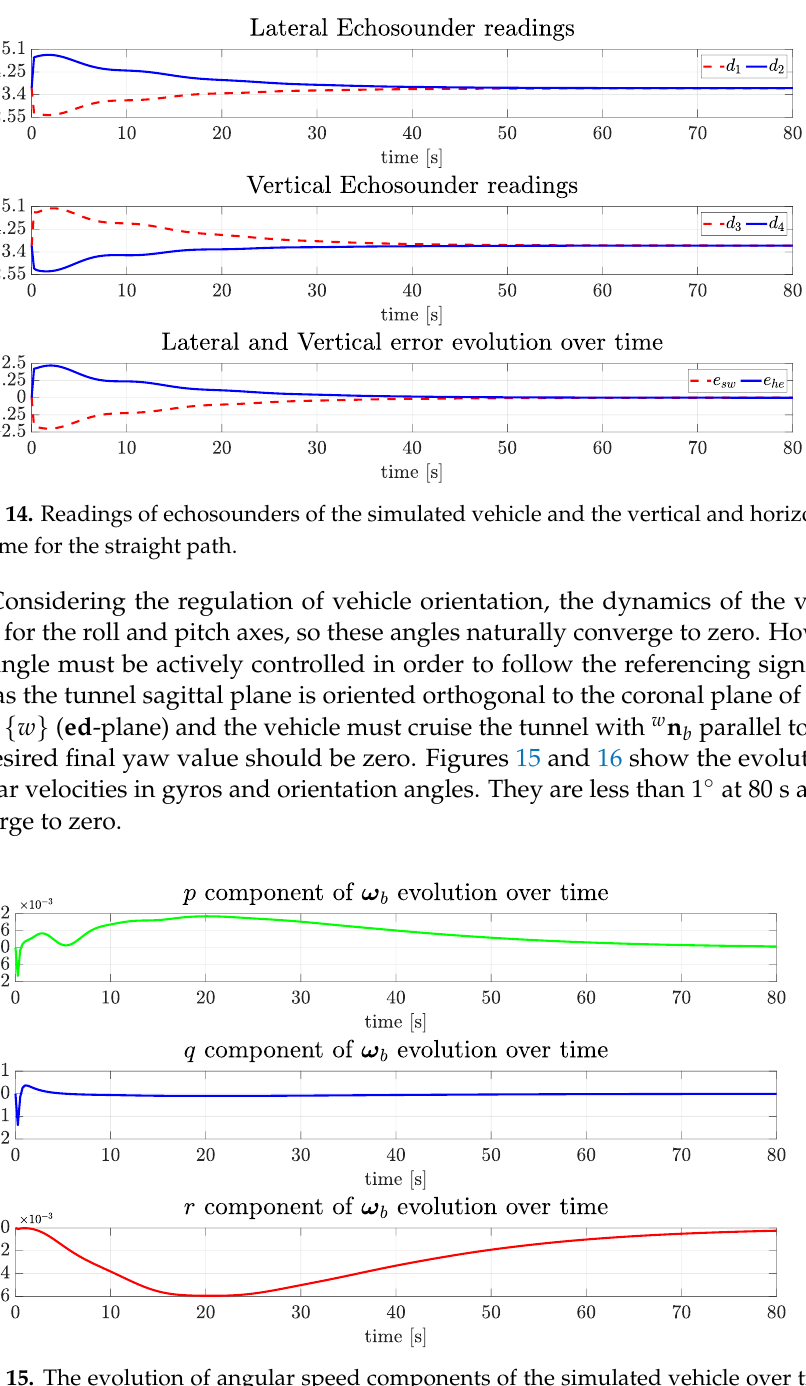
Figure 15. The evolution of angular speed components of the simulated vehicle over time for the straight